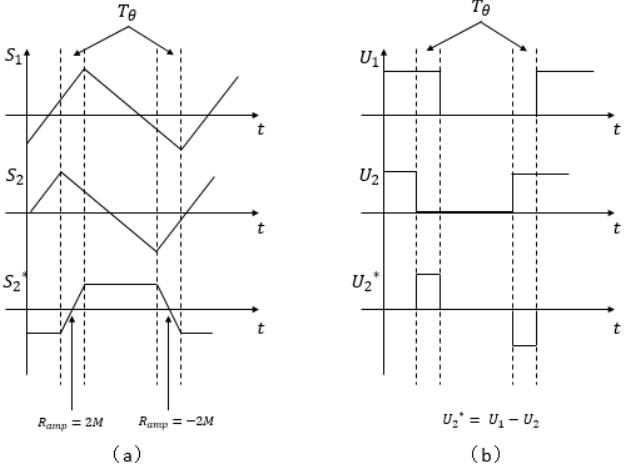
Figure 8. Phase delay between two phases: ( a ) s 1 and s 2 and ( b ) U 1 and U 2 .